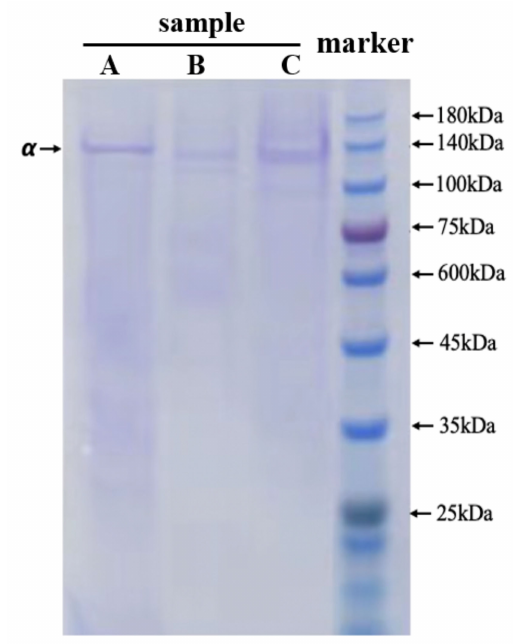
Figure 1. SDS-PAGE patterns of NTCII and standard protein marker. A—Pepsin solubilized colla- gen from chicken breast cartilage (presented by Shanghai Fisheries Research Institute), B—Pepsin- solubilized collagen from Andriasdavidianus cartilage (presented by Shanghai Fisheries Research Institute), C—Pepsin-solubilized collagen from Tilapia skull, and